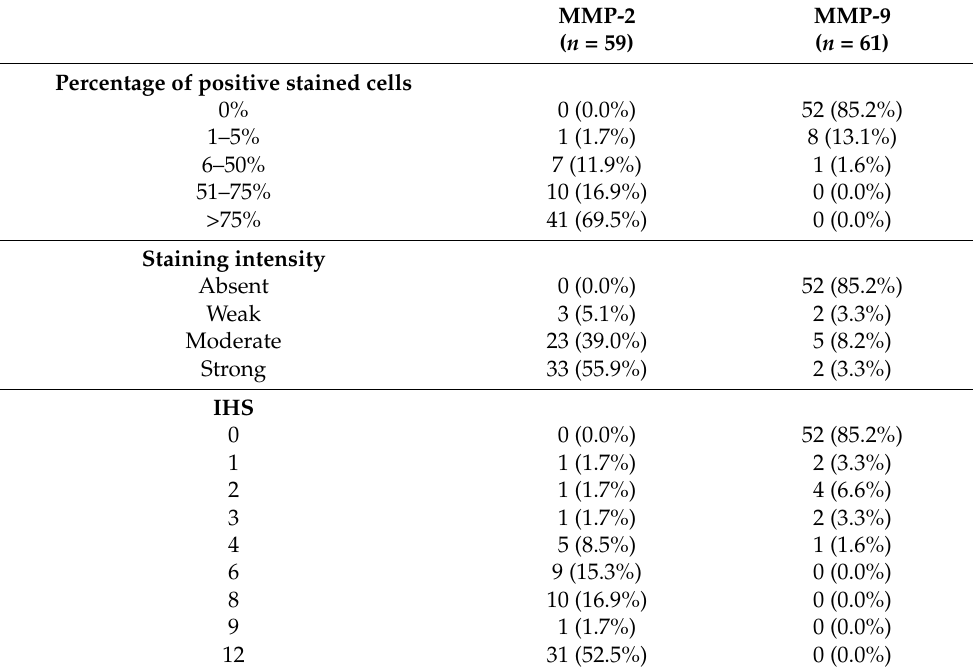
Table 3. Percentage of positively stained cells, staining intensity, and staining score (IHS) of MMPs-2 and -9 evaluated by IHC in GB tumor tissues.